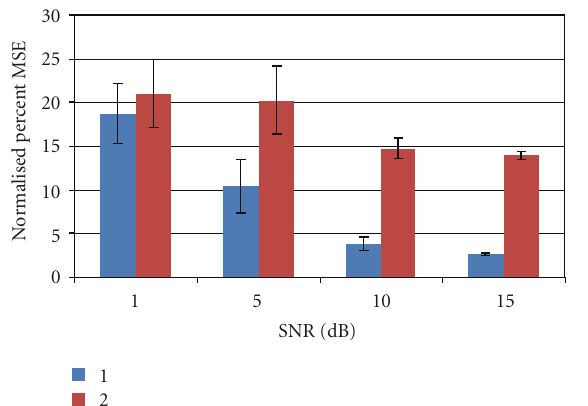
Figure 2: Comparison of reconstruction error (NPMSE, %) between Carmona’s (1) and Marseille (2) methods. All comparisons are significant at a level of 1%.